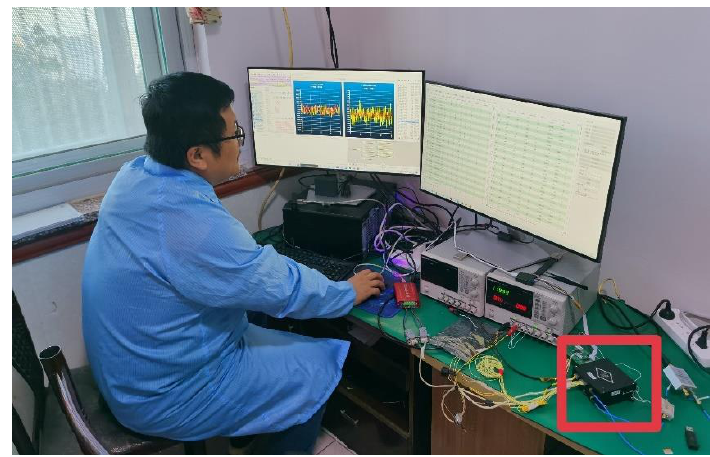
Figure 4 . Installation drawing of equipment room, our equipment is installed indoors, as shown in the figure (red marking part) and verified by the company’s self-researched occultation detector. It has the characteristics of small volume and low power consumption. It is also the equipment we will use in satellite networking in the future. It is placed on the anti-static pad, and ground treatment is also carried out to prevent the occurrence of static electricity and lightning strike events on the mountain.